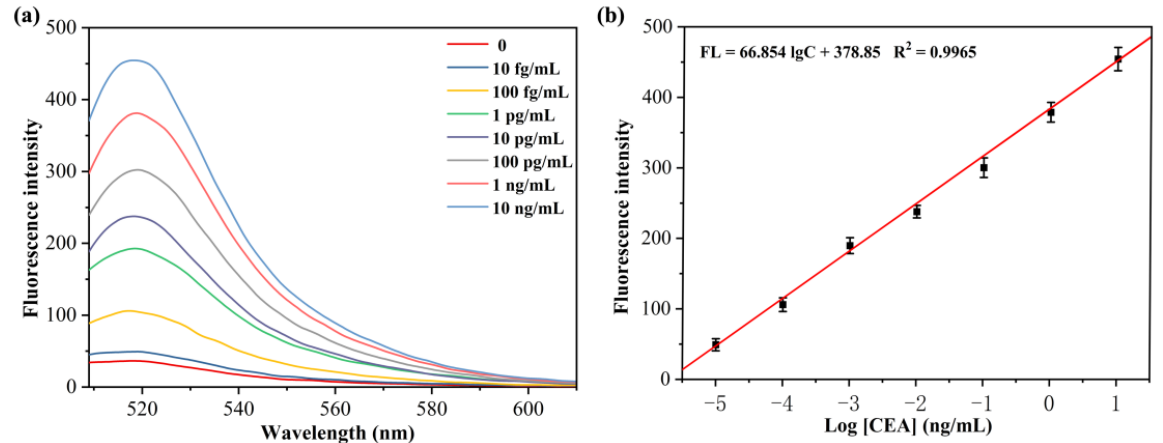
Figure 6. ( a ) Fluorescence spectra of the H probe/primer − 3/MB/KF/Nb.BbvCI solution after incubation with different concentrations of CEA. ( b ) Linear calibration curve of FL intensity at 520 nm versus the concentration of CEA.